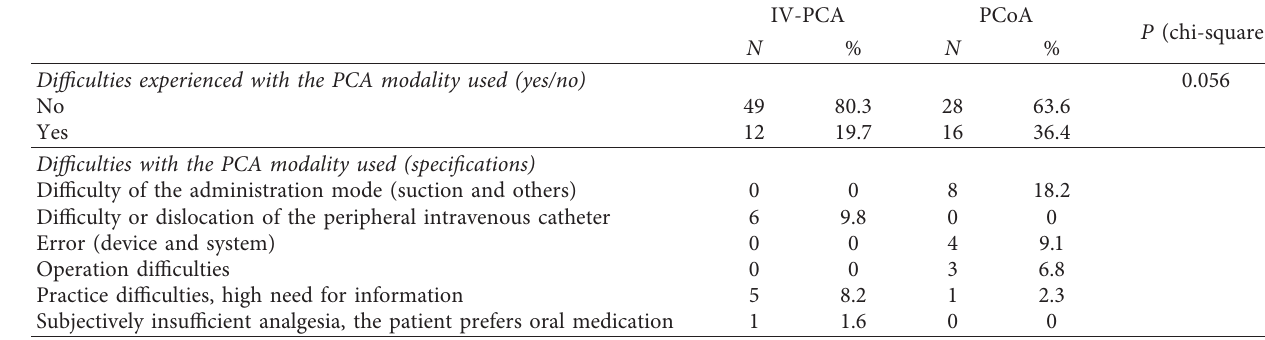
Table 5: Comparison of rate and specifications of difficulties with the PCA modalities by means of chi-square for independent